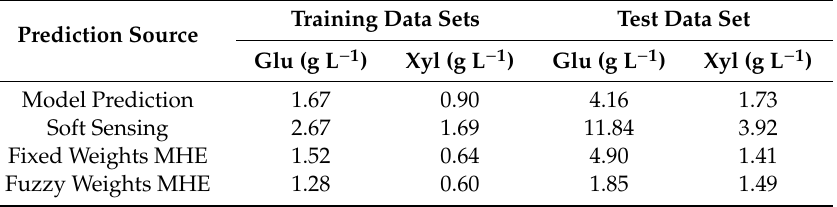
Table 5. Root Mean Squared Error (RMSE) for xylose and glucose predictions for Moving Horizon Estimator (MHE, window size of four elements), as well as pure model and soft